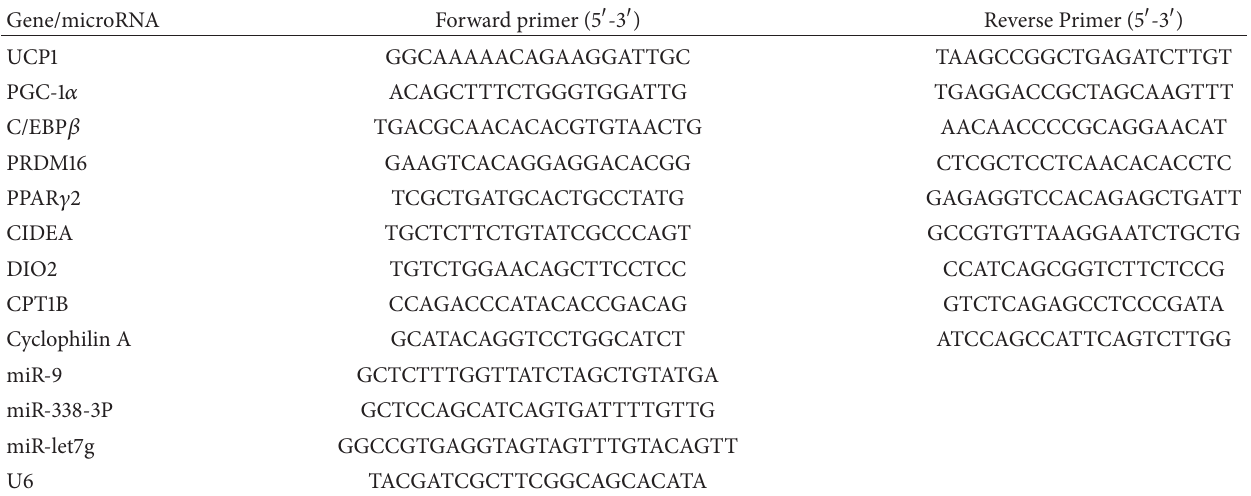
Table 1: Primer sequences for PCR